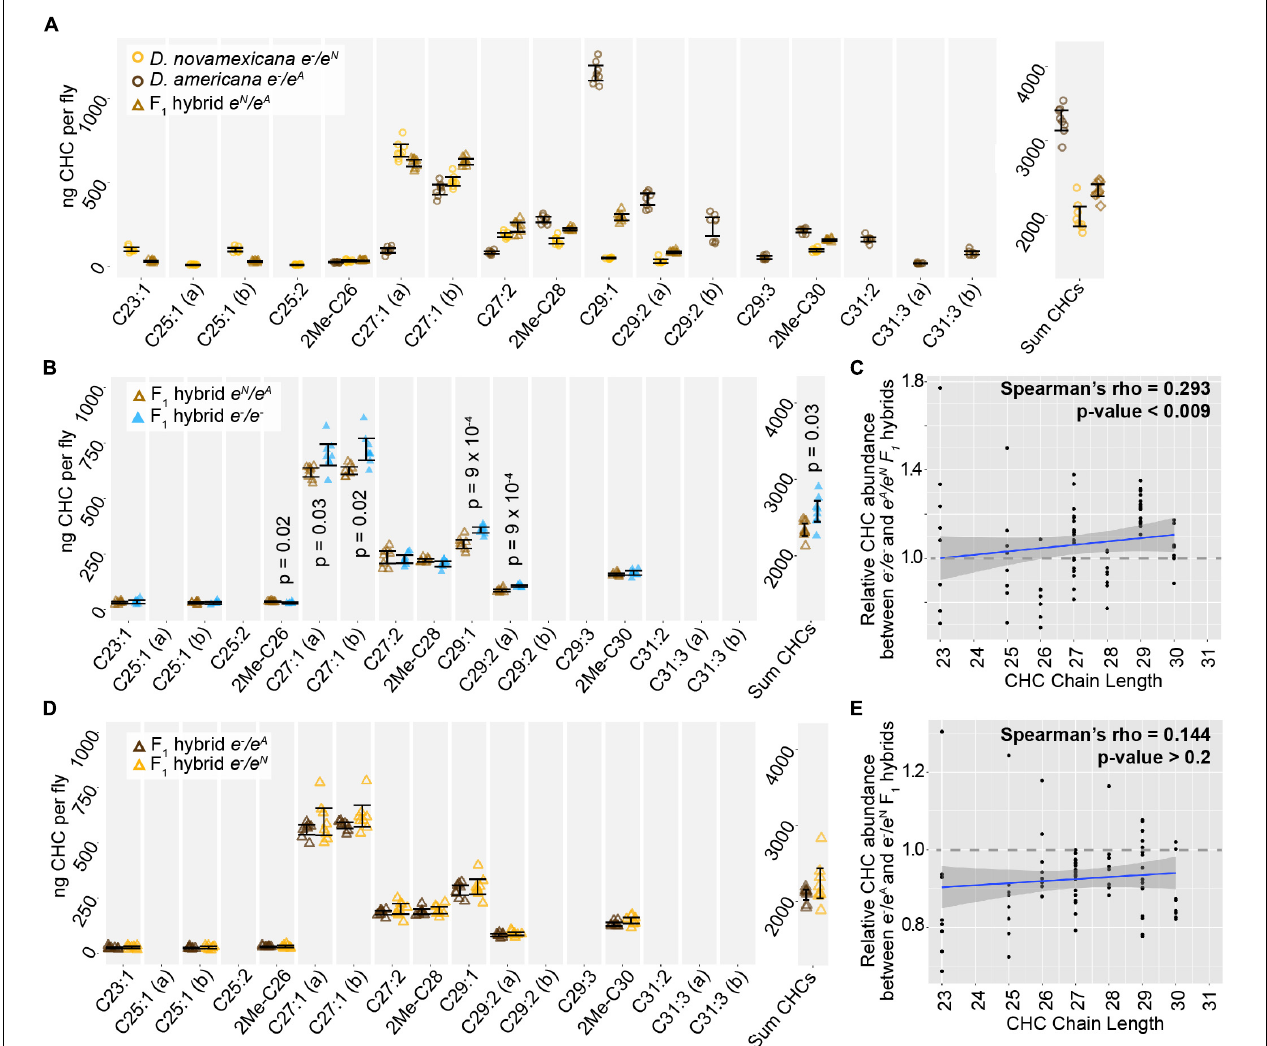
FIGURE 6 | ebony does not contribute to divergence of CHCs between D. americana and D. novamexicana . (A) Abundance of individual CHC compounds (ng/fly) and summed CHCs extracted from female flies are plotted for D. americana and D. novamexicana ebony heterozygotes as well as F 1 hybrids heterozygous for wild-type alleles of ebony . (B–C) CHCs from F 1 hybrids homozygous for ebony null alleles are compared to CHCs from F 1 hybrids with wild-type D. americana and D. novamexicana ebony alleles, showing the absolute abundance of individual and summed CHC compounds (B) as well as the relative abundance of CHCs by carbon chain length (C) . In panel (B) , p -values are shown from a Welch’s t -test with a Benjamini–Hochberg multiple test correction ( alpha = 0.05) when a significant difference in abundance was detected for a CHC present in both genotypes. (D–E) CHC profiles are plotted for reciprocal F 1 hybrids that differ only by which wild-type ebony allele they carry, either D. americana ( e A ) or D. novamexicana ( e N ), with absolute abundance of individual and summed CHCs shown in (D) and relative abundance of CHCs by chain length shown in (E) . No p -values are shown in (D) because no CHCs showed a statistically significant difference in abundance between the two F 1 hybrid genotypes from the reciprocal hemizygosity test (Welch’s t -test with Benjamini–Hochberg multiple test correction, p > 0.05 for each CHC). In panels (C,E) , blue trendlines show linear regressions, with shaded areas representing the standard error and both Spearman’s rho and p -values indicated on each plot. In all panels, data from eight replicate flies is shown for each